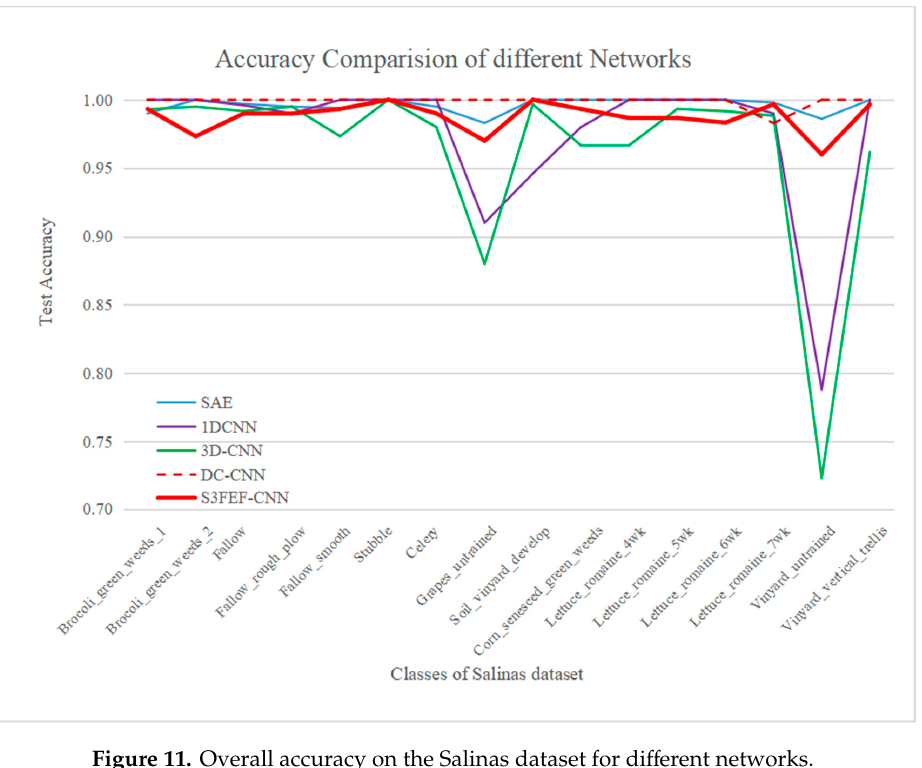
Figure 11. Overall accuracy on the Salinas dataset for different networks.